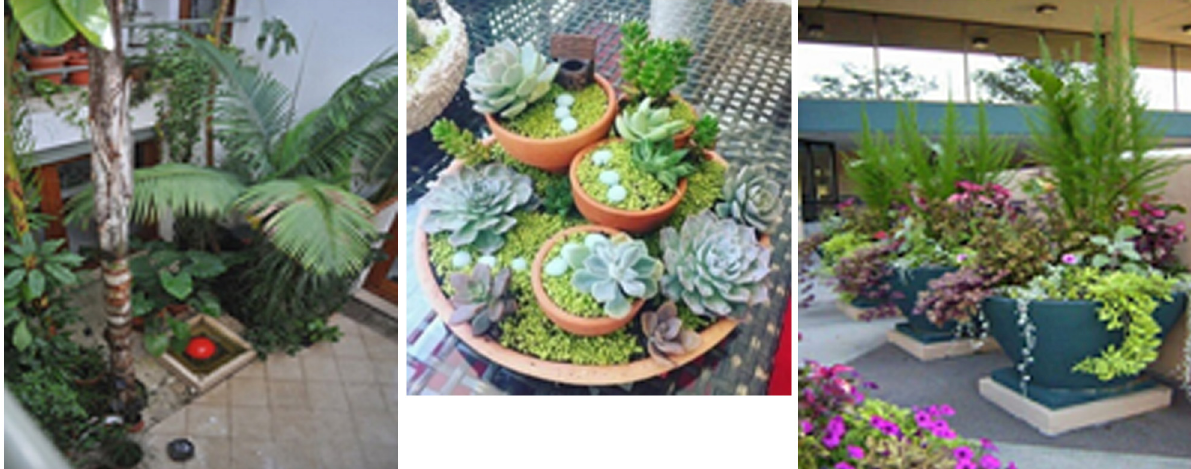
Fig. 12. Type of plants that can be grown in courtyards which have resistant to heat, dust, and require